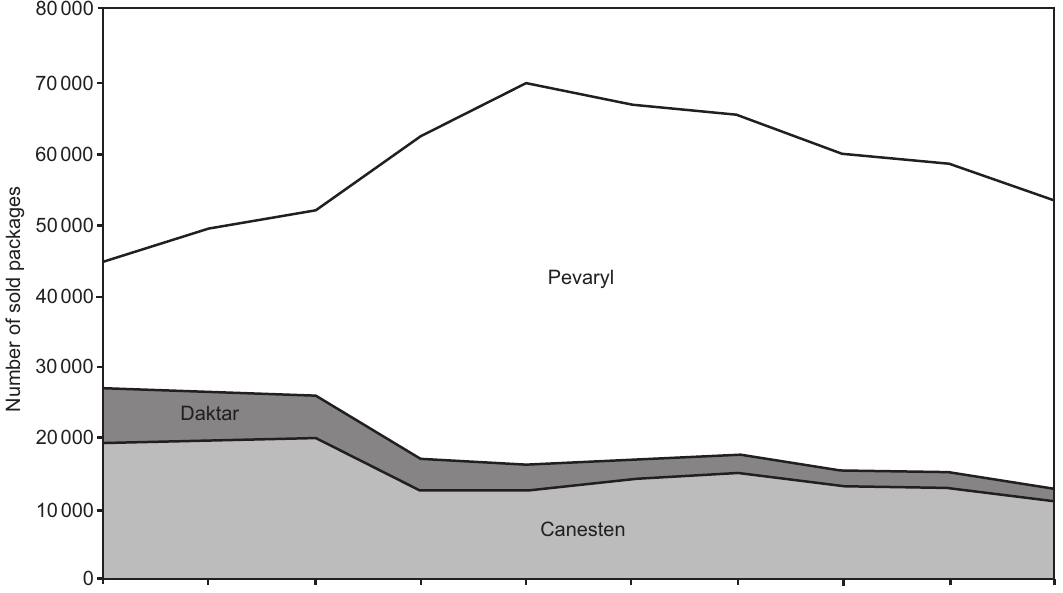
Figure 1 Total usage of vaginal preparations of econazole (Pevaryl 1 ), miconazole (Daktar 1 ) and clotrimazole (Canesten 1 ), sold either by prescription or as over-the-counter products in Ska˚ne county, Sweden, during the 1990s